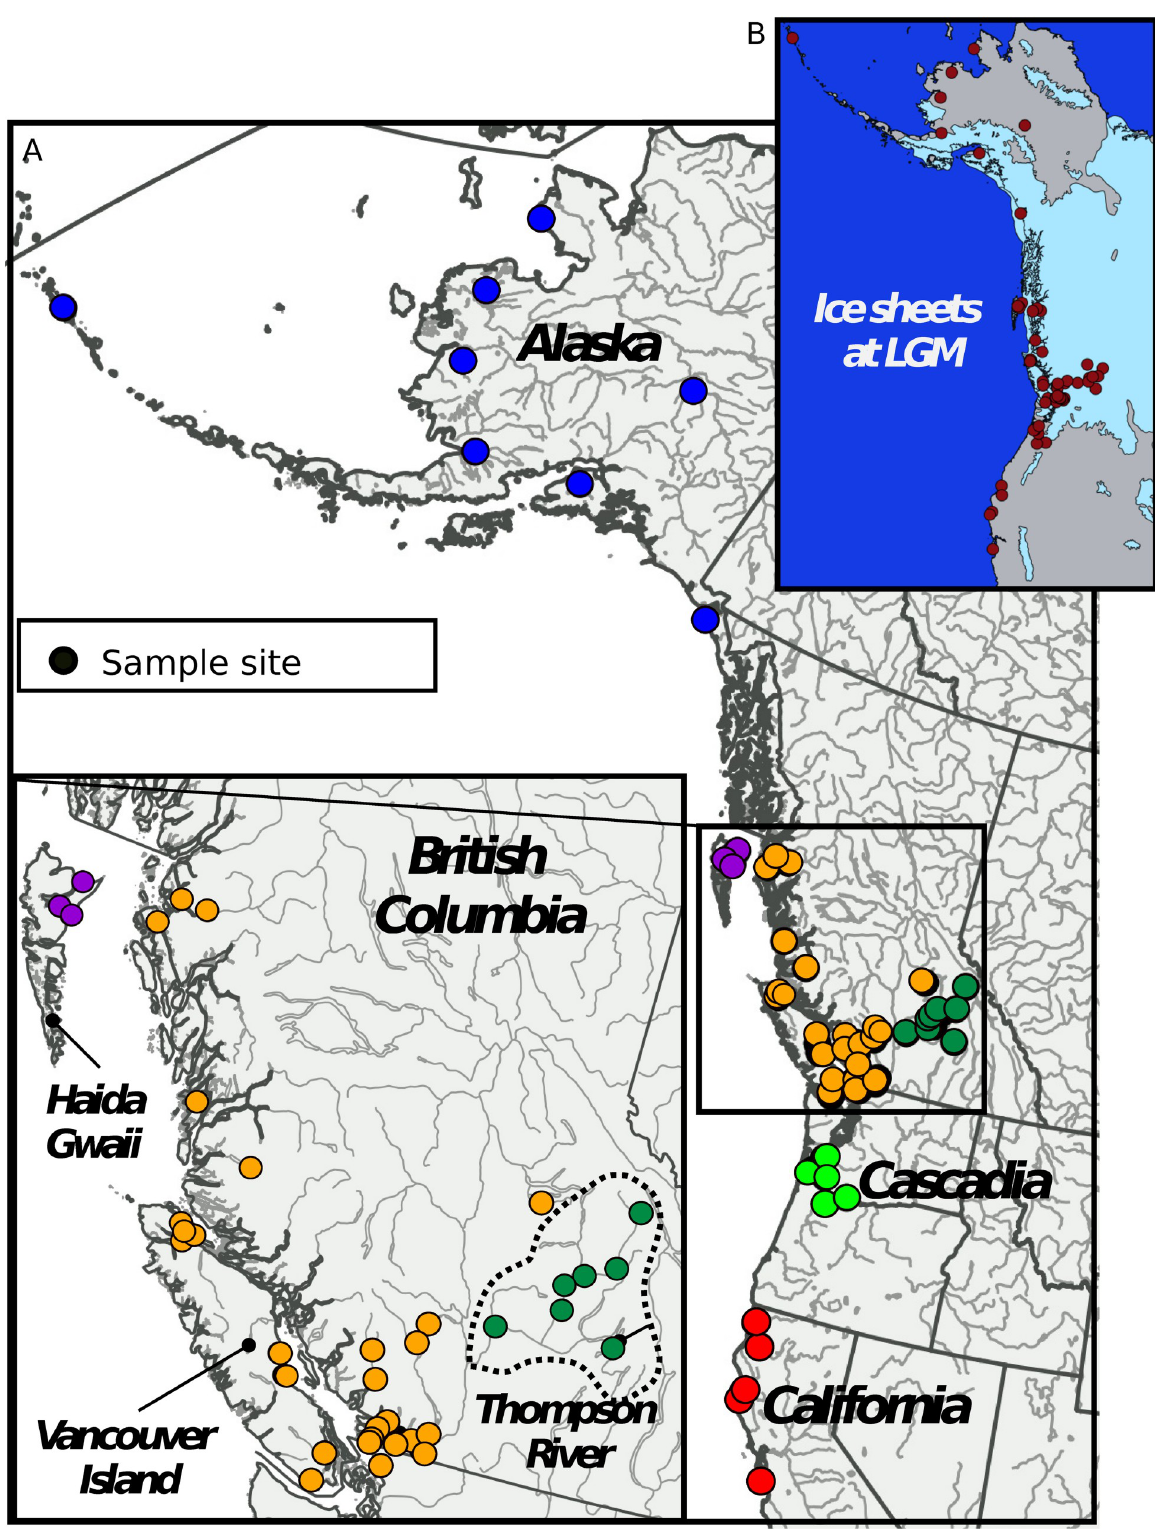
Fig 1. Sampling design. A) Sampling locations of 58 Coho salmon populations distributed across the species’ North American range. Each dot represents a sampling location. B) Map showing the extent of ice-sheet during the Last Glacial Maximum 13 Kya. Map drawn with Qgis software using data from [94,